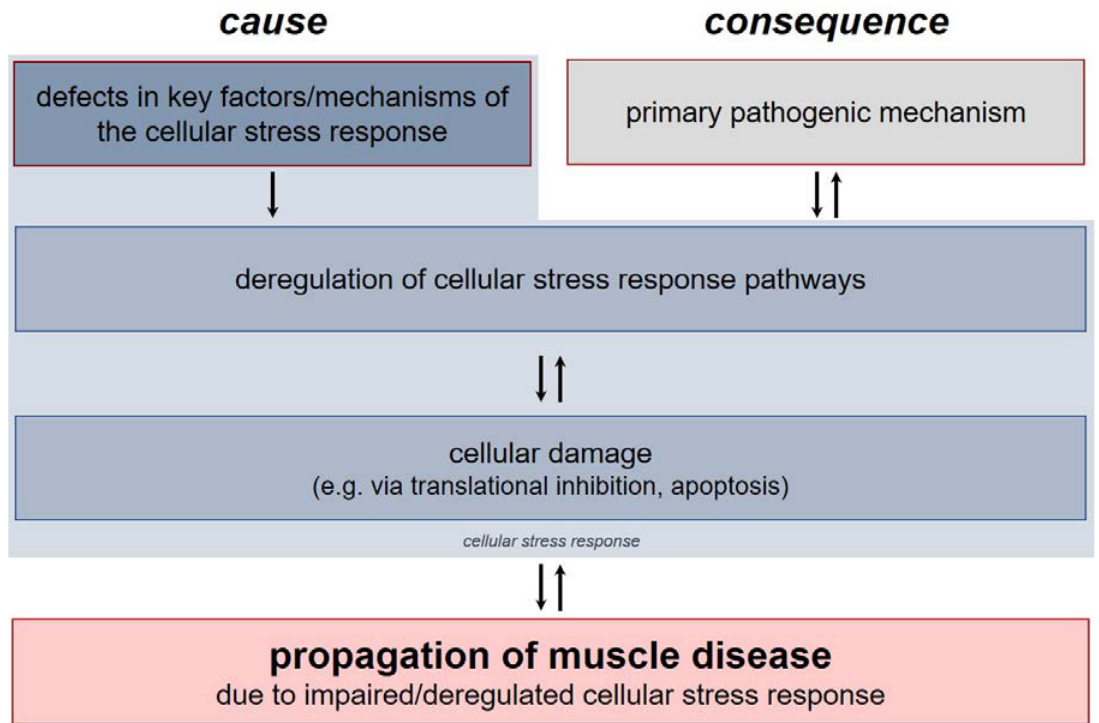
Figure 1. General principles of stress response-related pathogenesis in muscular disorders. While there are some muscular disorders that emerge from defects in key factors or mechanisms of the cellular stress response (‘cause’), in most muscle diseases, the deregulation of cellular stress response pathways arises as result of another pathogenic mechanism (‘consequence’).